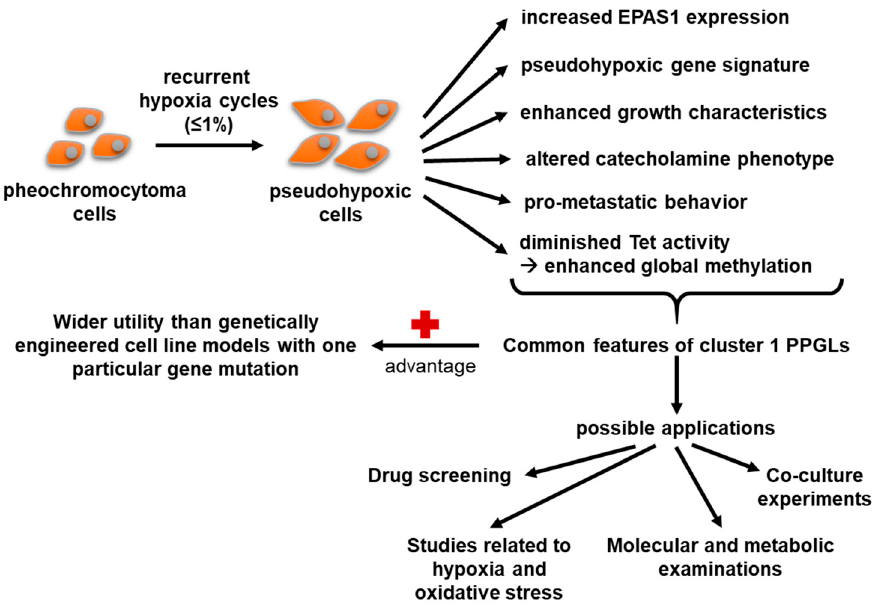
Figure 6. Characteristics and possible applications of the new established PC12 sub-cell